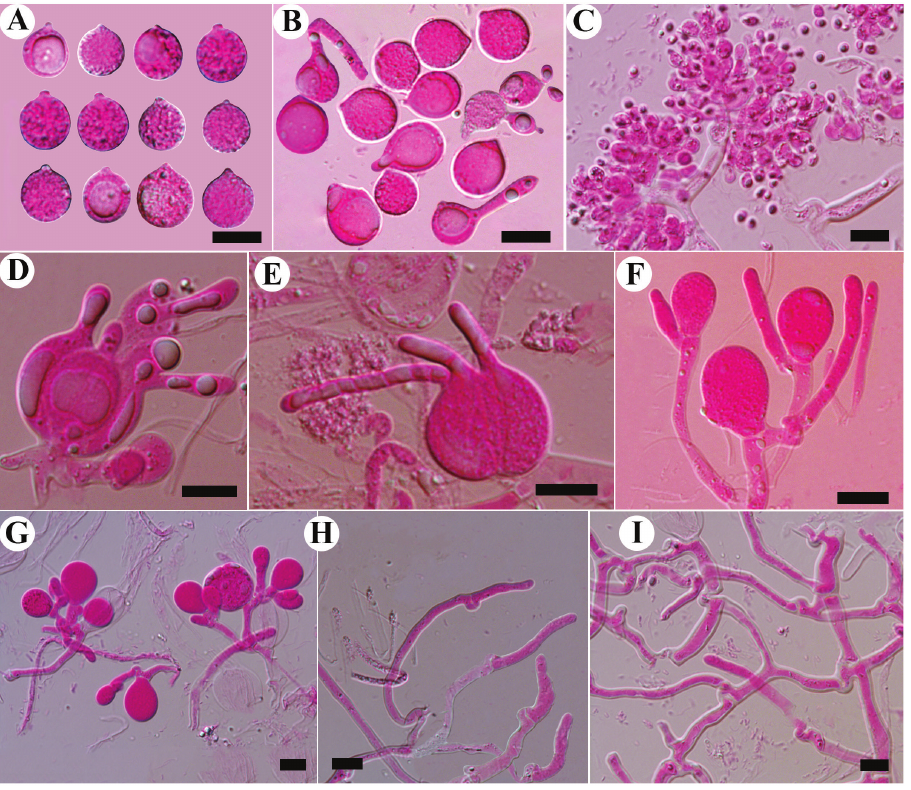
Figure 7. Microscopic structures of Tremella latispora (Dai 17568) A basidiospores B germination tubes of basidiospores and secondary spores C conidia and conidiophores D, E basidia F, G probasidia H, I hyphae with clamp connections and clamp complexes. Scale bars: 10 µm ( A–I